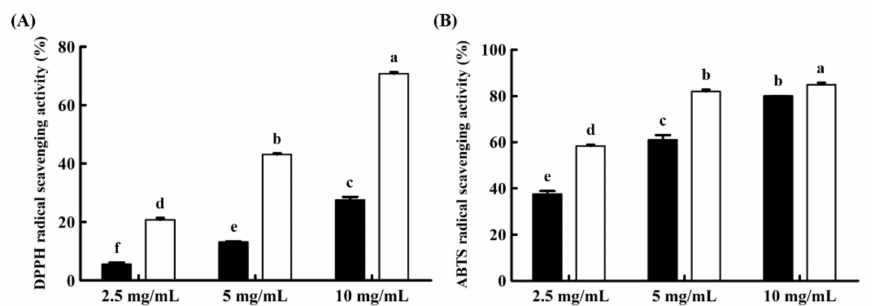
Figure 1. Antioxidant activity of ginseng extracts. Two radical scavenging assays were performed, ( A ) 2,2-diphenyl-1-picryl-hydrazyl (DPPH) and ( B ) 2-azinobis-(3-ethylbenzothiazoline-6-sulfonic acid) diammonium salt (ABTS). (cid:4) , soil-cultured ginseng extract; (cid:3) , hydroponic ginseng extract. The graphs are expressed as mean value ± S.D. of triplicate experiments. Different letters represent significant differences between treated samples within one antioxidative analysis ( p <